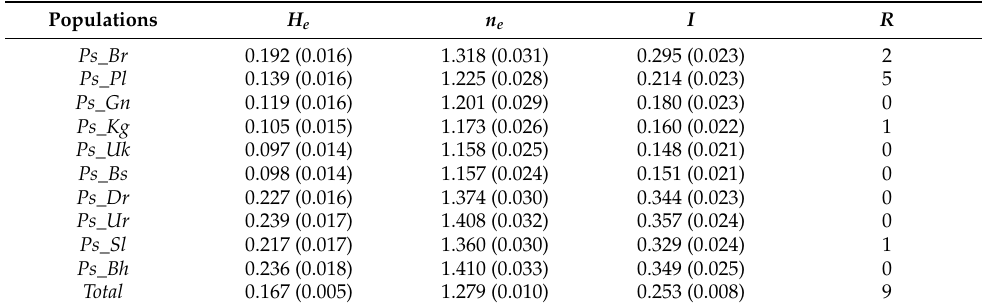
Table 2. Genetic diversity of the studied populations of P. sylvestris.